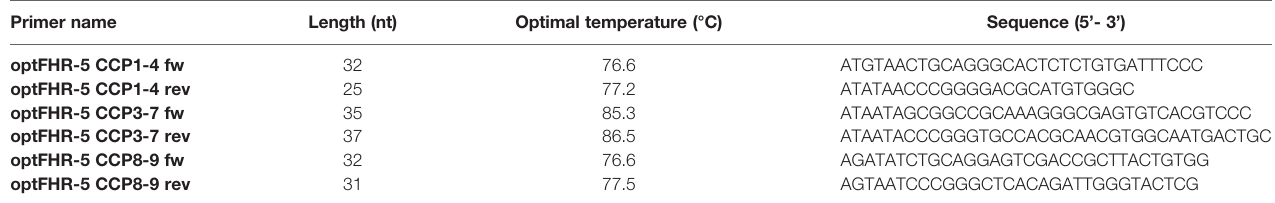
TABLE 1 | The primers used to generate the FHR5 fragments used in this